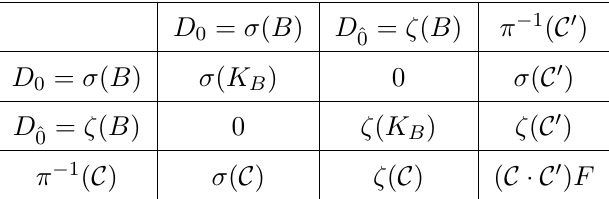
Table 5 . Intersection properties of two divisor classes. Here, C and C 0 are two curve classes on the